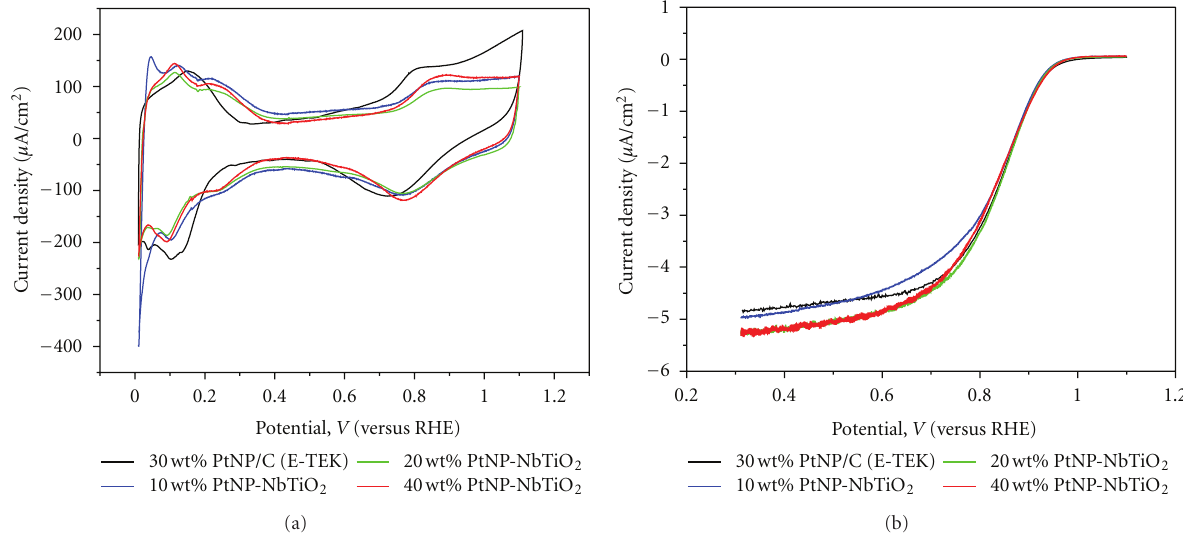
Figure 5: (a) CV curves and (b) polarization curves for O 2 reduction on commercial ETEK Pt/C catalyst and Nb-doped TiO 2 with di ff erent Pt NP loadings in a 0.1 M HClO 4 solution on a disk